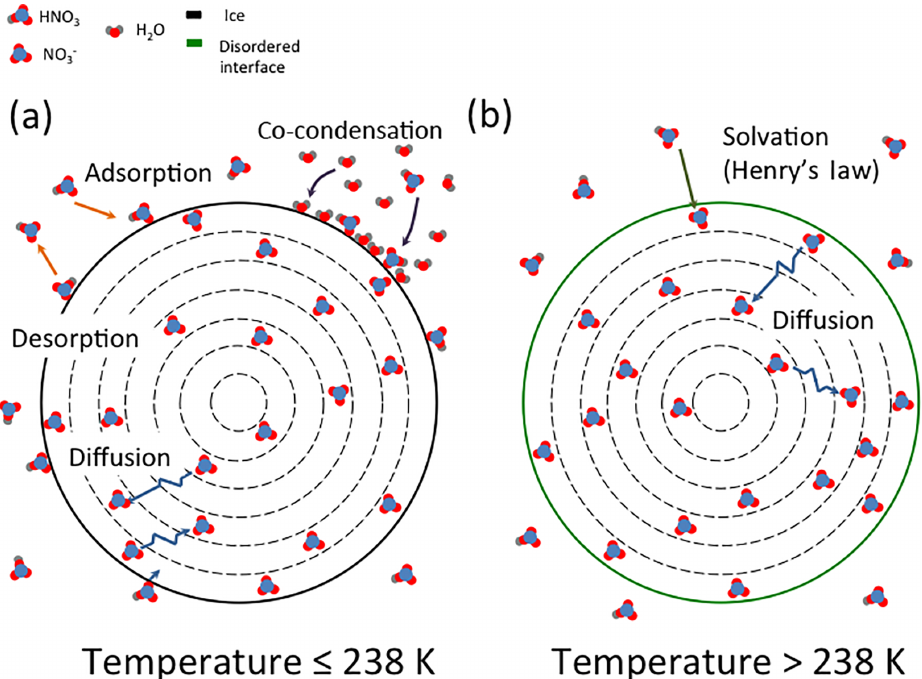
Figure 1. Schematic of Model 1. (a) At T ≤ 238K the concentration of NO − processes, i.e. non-equilibrium adsorption and co-condensation. (b) At T > 238K the concentration NO − grain is determined by air–DI processes, i.e. non-equilibrium solvation into